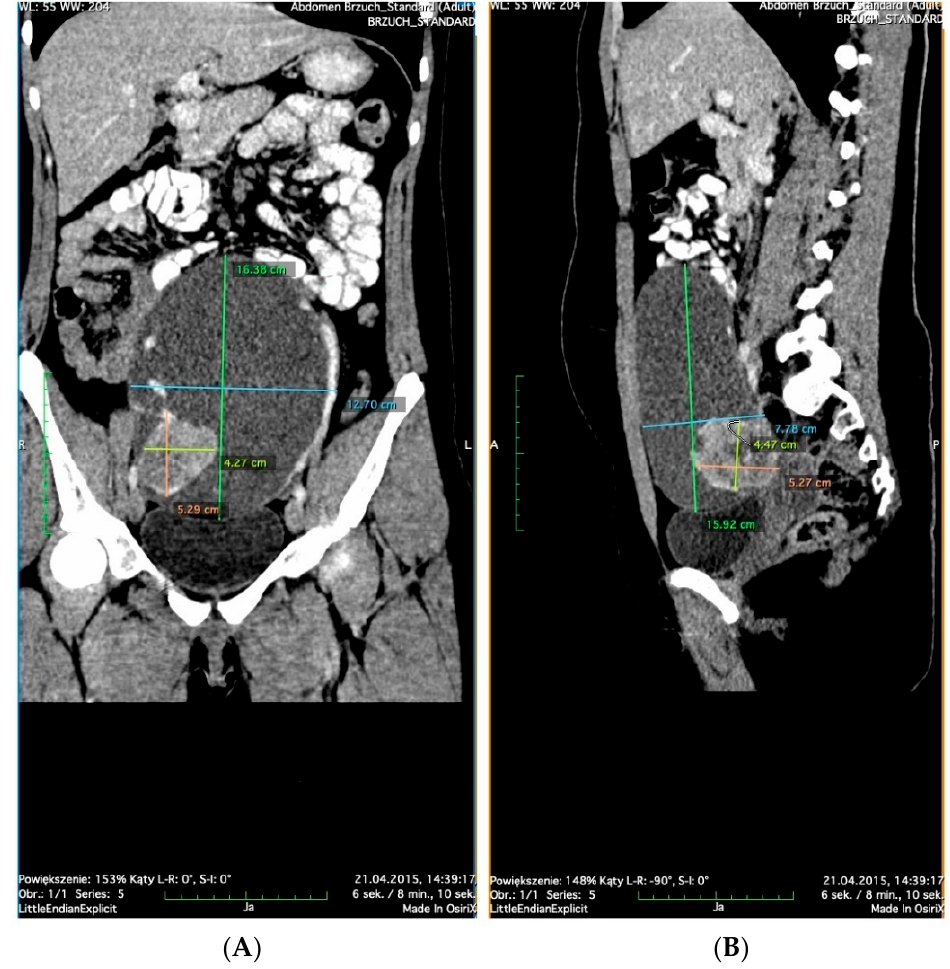
Figure 1. CT scans of the abdominal cavity and pelvis, which revealed a vast cystic-solid lesion: ( A ) coronal CT; ( B ) sagittal CT.